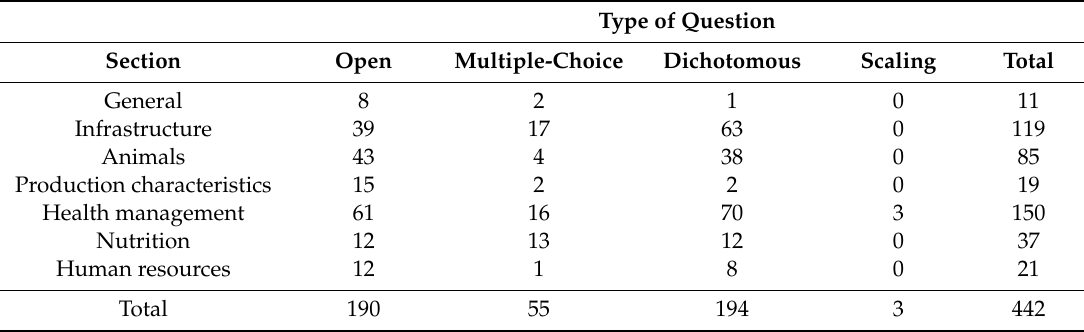
Table 1. Types of questions (n) in the questionnaire according to the various sections therein.